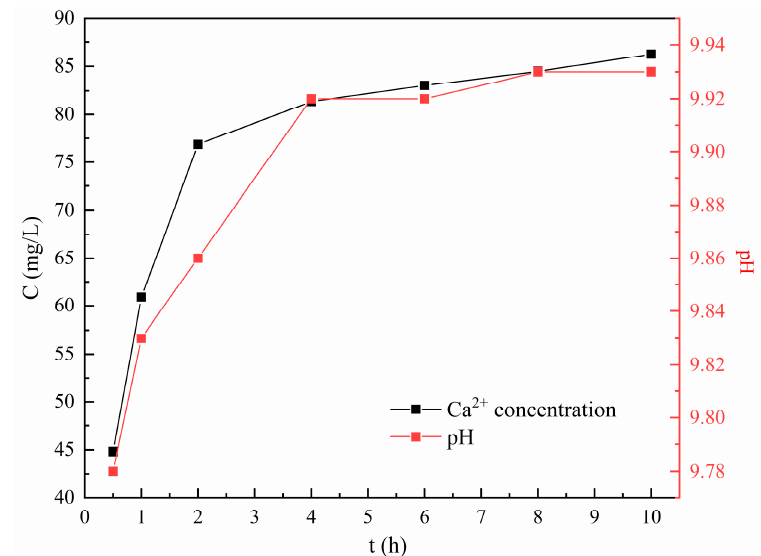
Figure 3. Releasing ability of tobermorite.